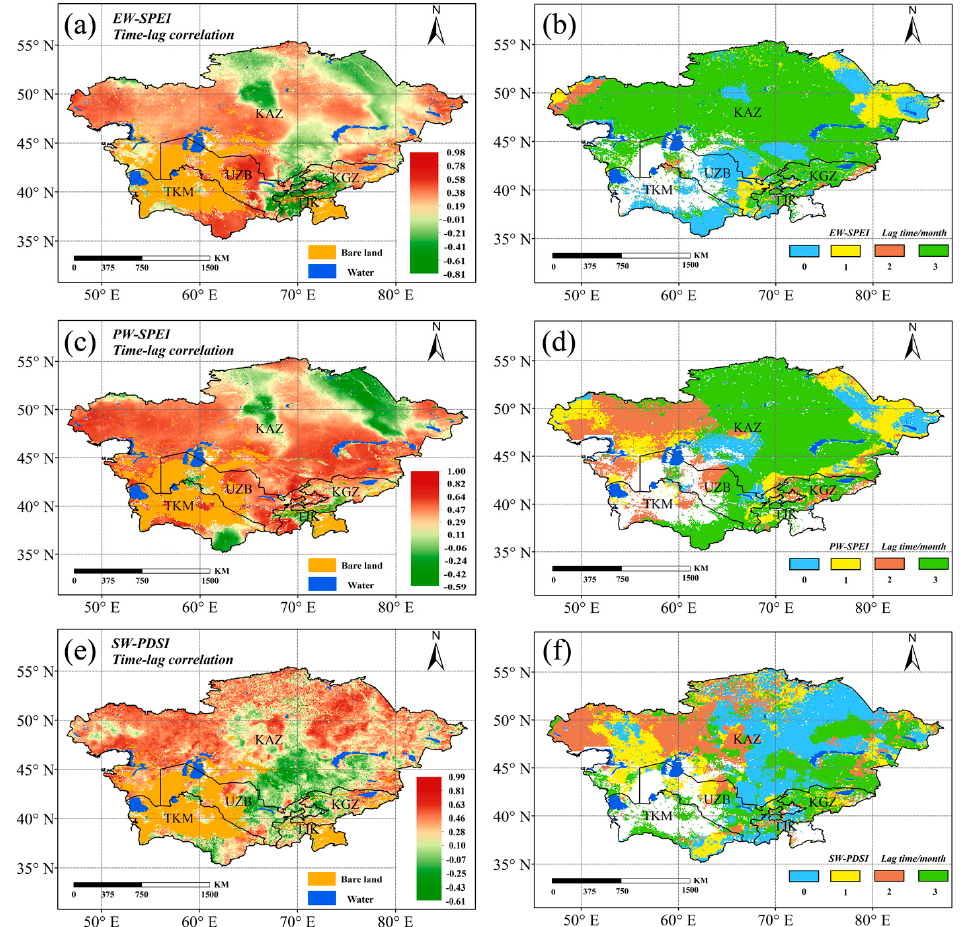
Figure 7. Maximum time-delay correlation coefficient: ( a ) EW-SPEI, ( c ) PW-SPEI, ( e ) SW-PDSI and lag time, ( b ) EW-SPEI, ( d ) PW-SPEI, ( f ) SW-PDSI between WUE and drought (SPEI and PDSI) in Central Asia. (LCC: Maximum time-delay correlation coefficient.).